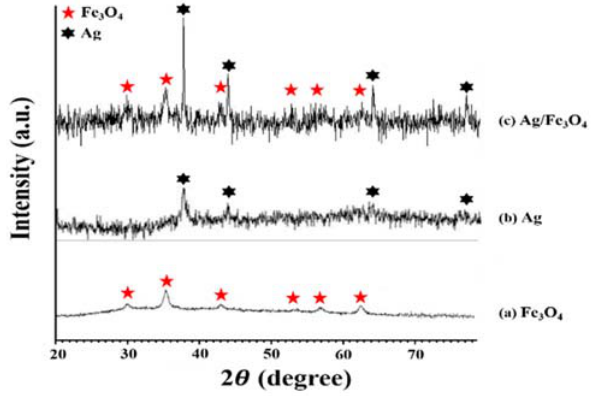
Figure 4. X ‐ ray diffractometer ( XRD) patters of the prepared nanoparticles: ( a ) Fe 3 O 4 ; ( b ) Ag; and ( c ) Ag/Fe 3 O 4 .